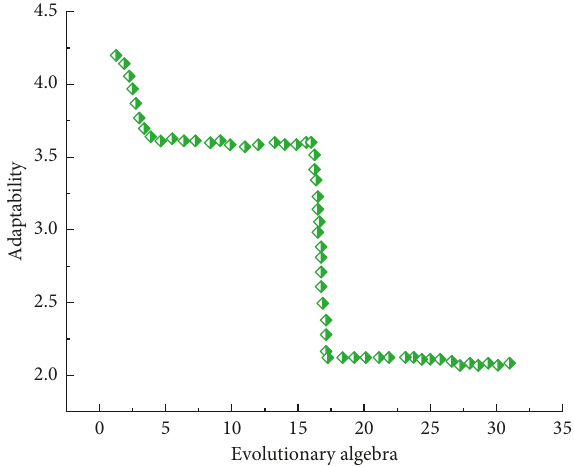
Figure 7: Typical time history curve of signal. Figure